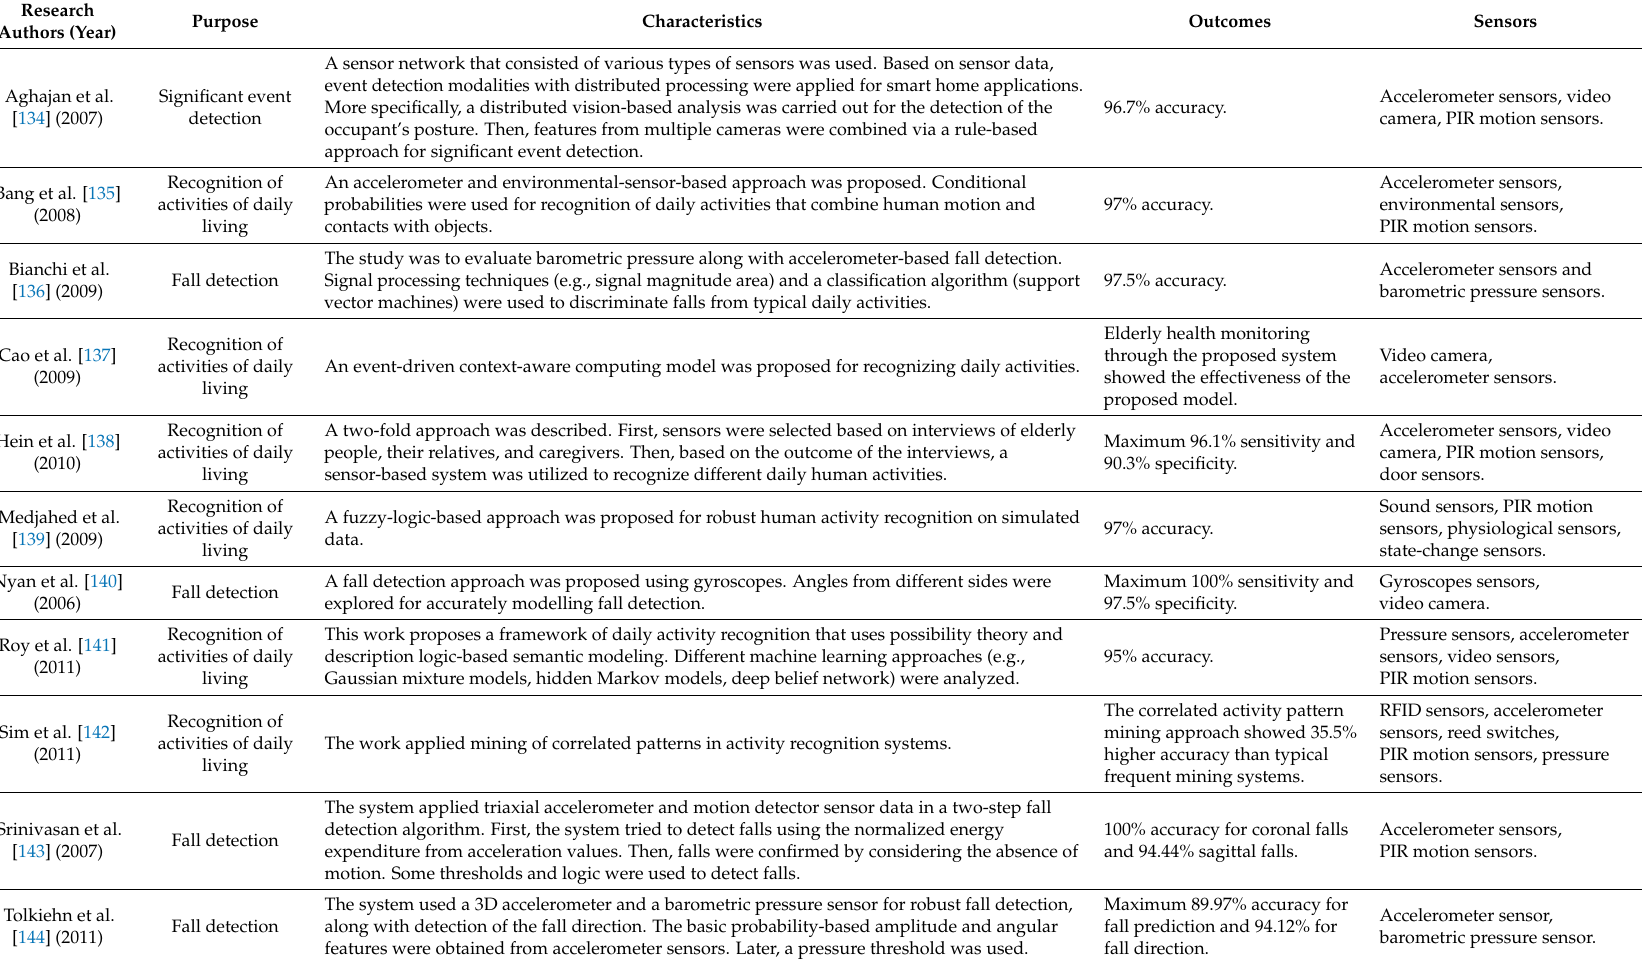
Table 9. Summary of research works that use ambient and wearable sensor